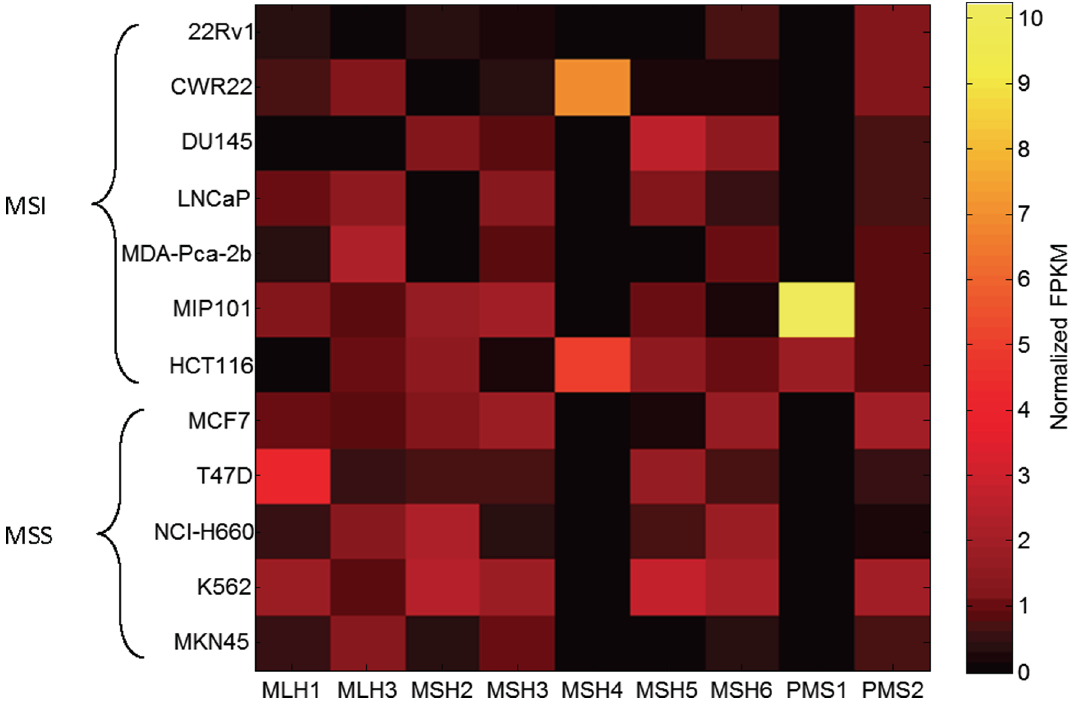
Figure 6. Expression levels of MMR genes shown in FPKM values for MSI/MSS cell lines. Values are normalized by the mean value of each column.